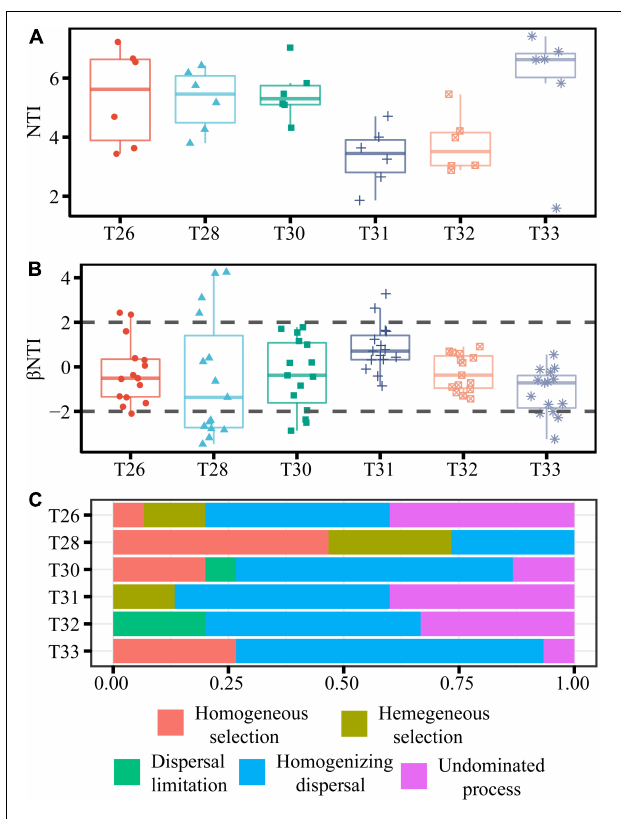
FIGURE 6 | Relative influences of deterministic and stochastic processes on community assembly. (A,B) Are the boxplots of the NTI and β NTI for all pairs of communities within coral samples at different temperatures. (C) The percentage of turnover in community assembly governed primarily by various deterministic and stochastic